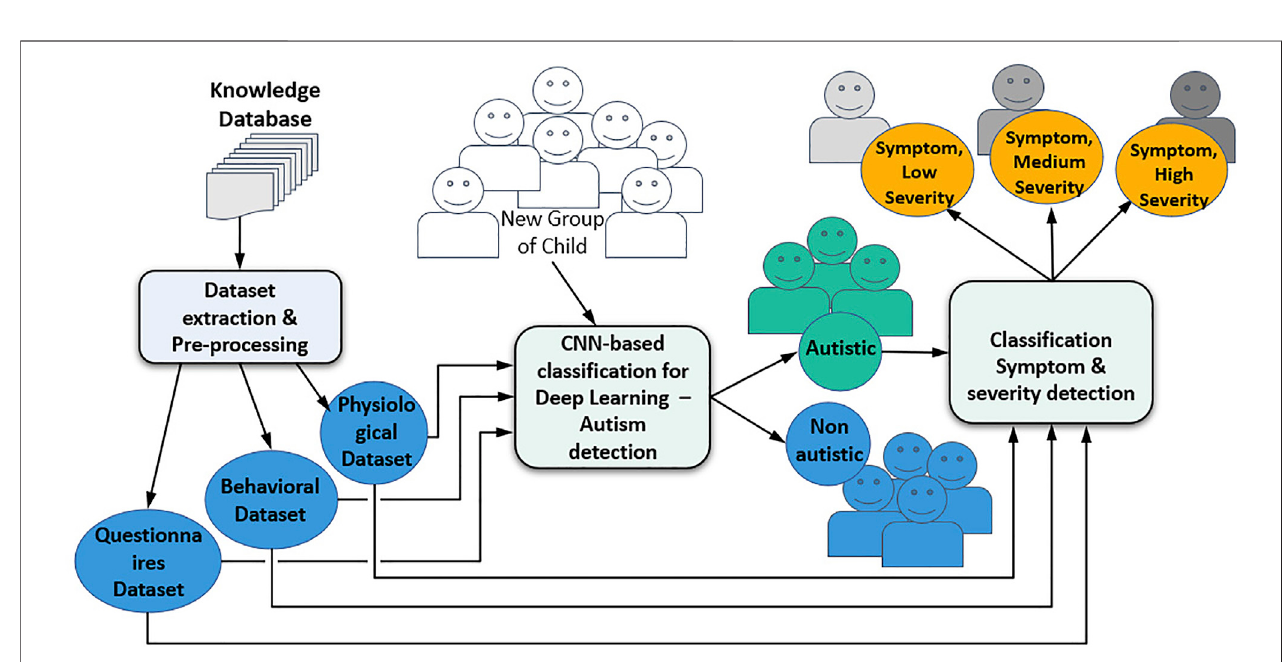
FIGURE 4 | The child classi fi cation and symptom discovery